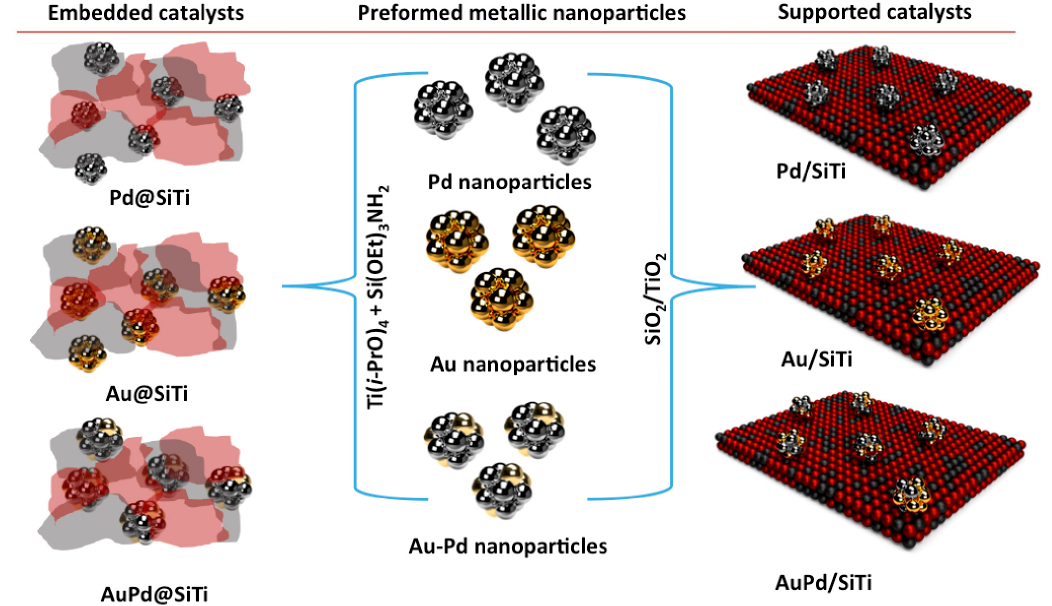
Figure 1. Schematic representation of the compared catalytic systems. Embedded catalysts are denoted as Au x Pd y @SiTi and supported catalysts as Au x Pd y /SiTi (red—TiO 2 , gray—SiO 2 ).